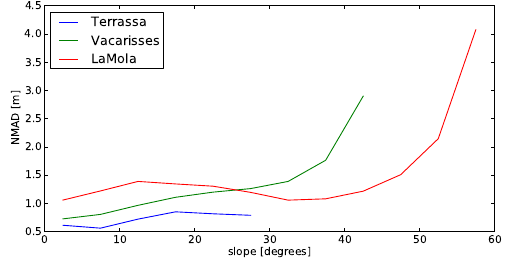
Figure 4: Dependency of DSM error on surface slope for Worldview-1